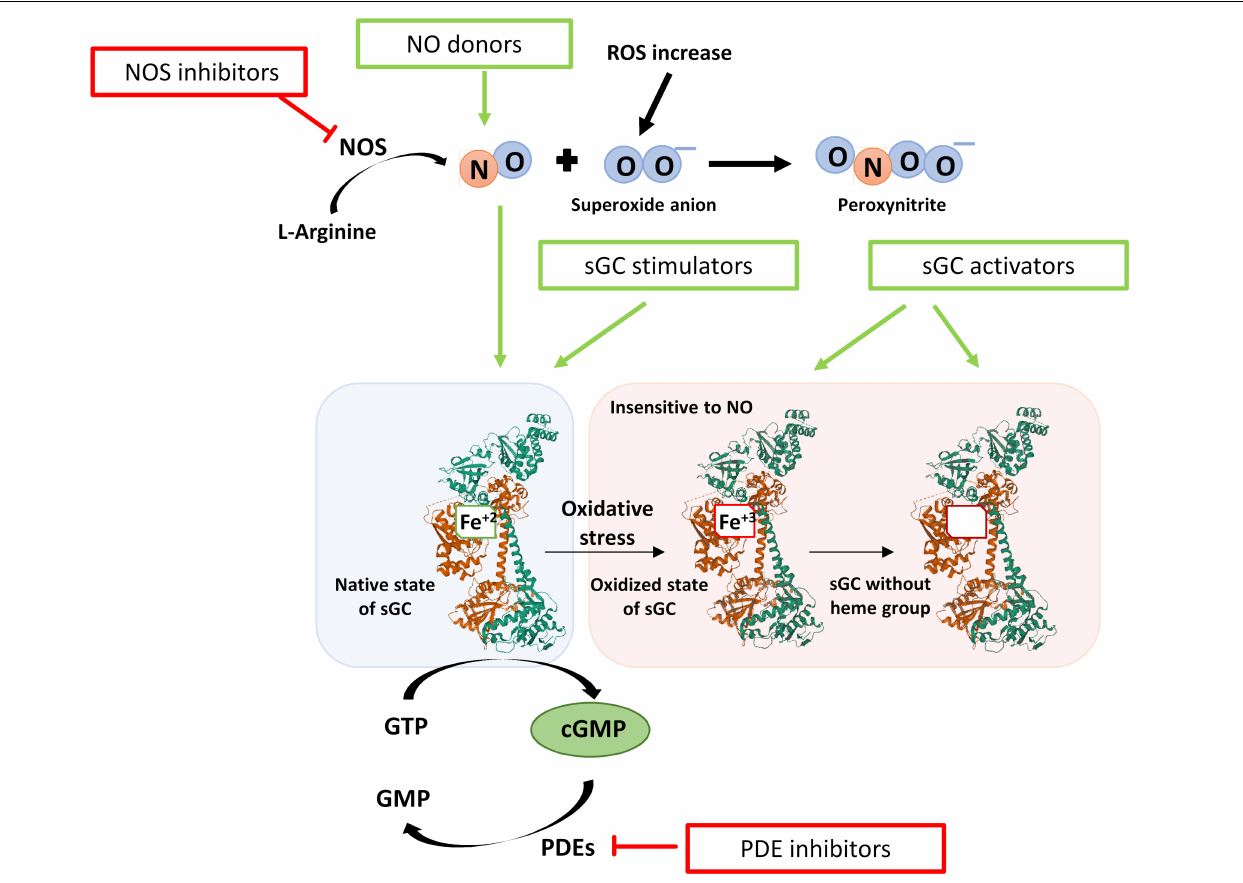
FIGURE 7 | Scheme of the redox state of the sGC enzyme and the modulatory drugs that act on the NO- sGC-cGMP pathway. After oxidative stress, the heme group is oxidized (Fe + 3 ), and the sGC enzyme is insensitive to NO. In addition, the oxidized heme group loses affinity for the enzyme and is released. The drugs that can modulate this axis are NO donors, iNOS inhibitors, PDE5 inhibitors, and sGC modulators. sGC modulators increase the activity of sGC and thus the formation of cGMP independently of NO and are classified as stimulators or activators of sGC. Stimulators of sGC act when the heme group is reduced (Fe + 2 ). Activators of sGC can activate the enzyme even when the heme group is oxidized (Fe + 3 ) or